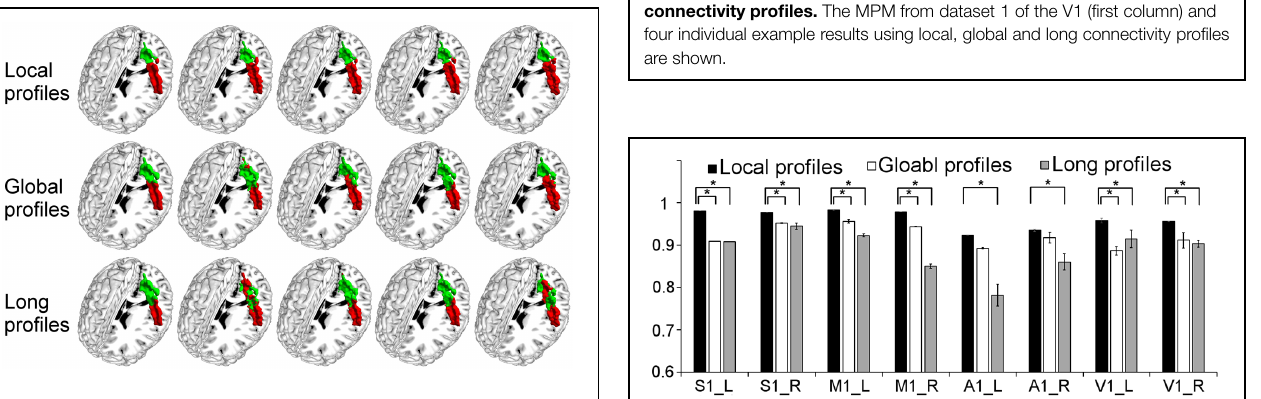
FIGURE 5 | The primary somatosensory cortex (S1) in the left hemisphere was parcellated into two subregions using local, global, and long connectivity profiles. The MPM from dataset 1 of the S1 (first column) and four individual example results using local, global, and long connectivity profiles are shown.